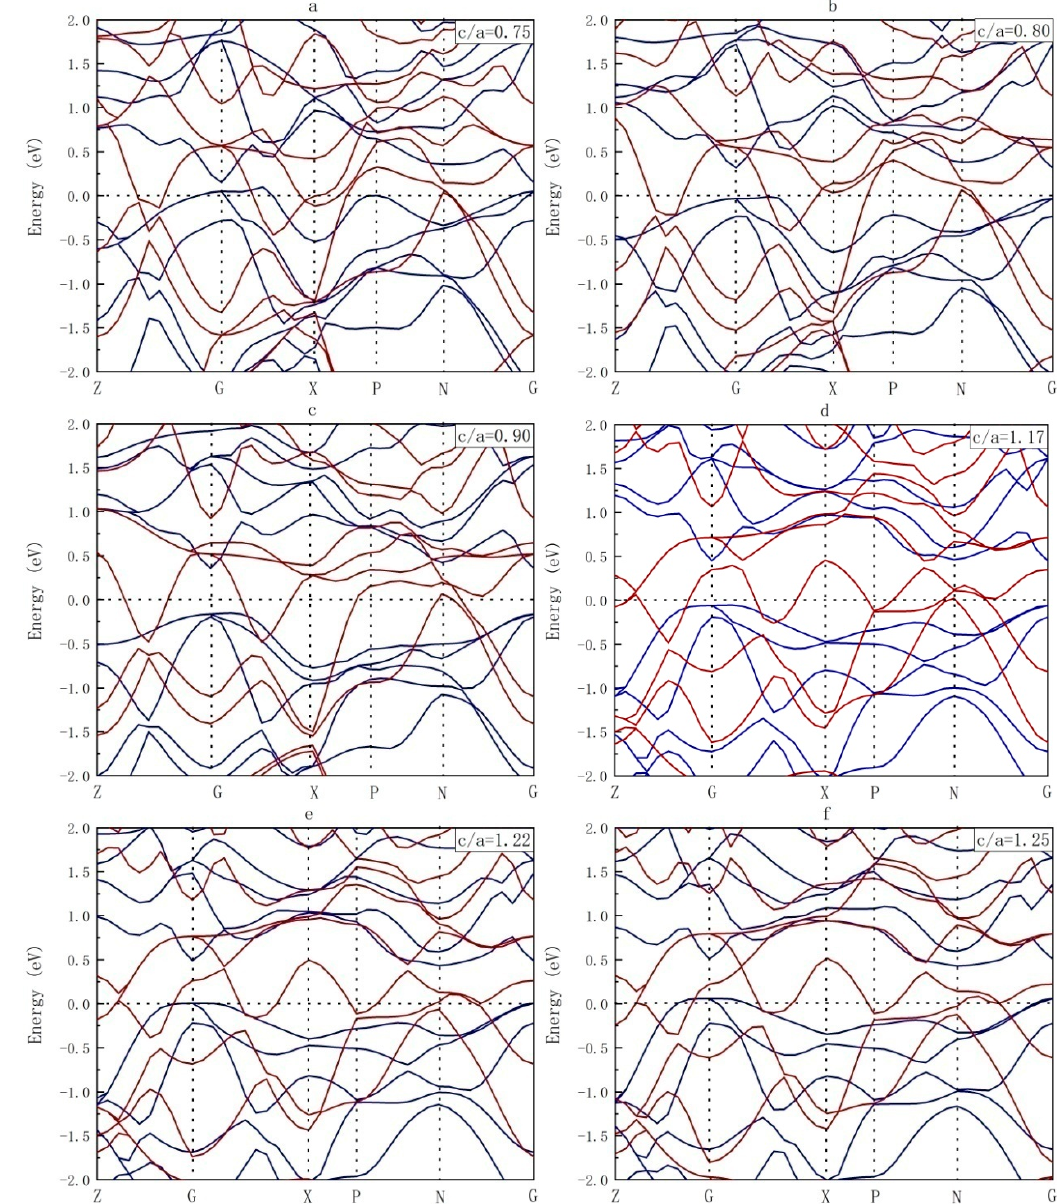
Figure 7. Band structures for the XA-type Sc 2 VGe at its tetragonal distortion lattice Figure 7. band structures for the XA-type Sc 2 VGe at its tetragonal distortion lattice parameters.